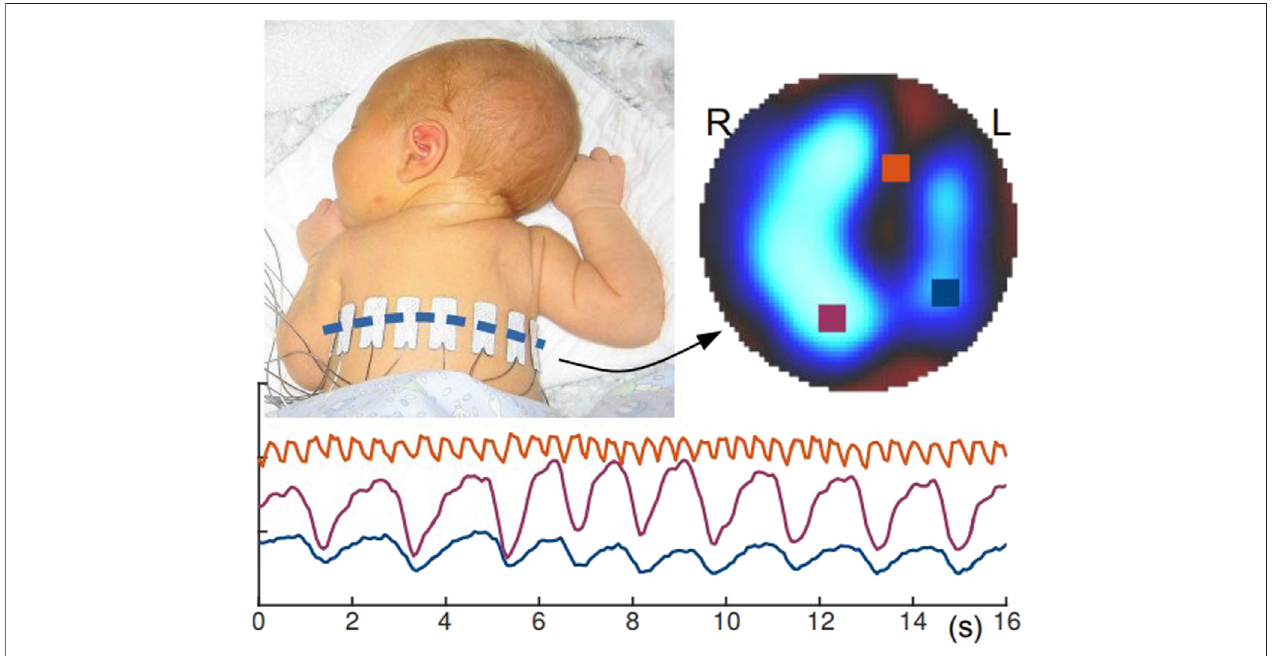
FIGURE9| A10-day-oldinfantwithEITelectrodes(Heinrichetal.,2006).Byperforminglungfunctionimagingofnewborns,timelydiagnosisandtreatment oflung diseases in early development of newborns without radiation damage can be done.